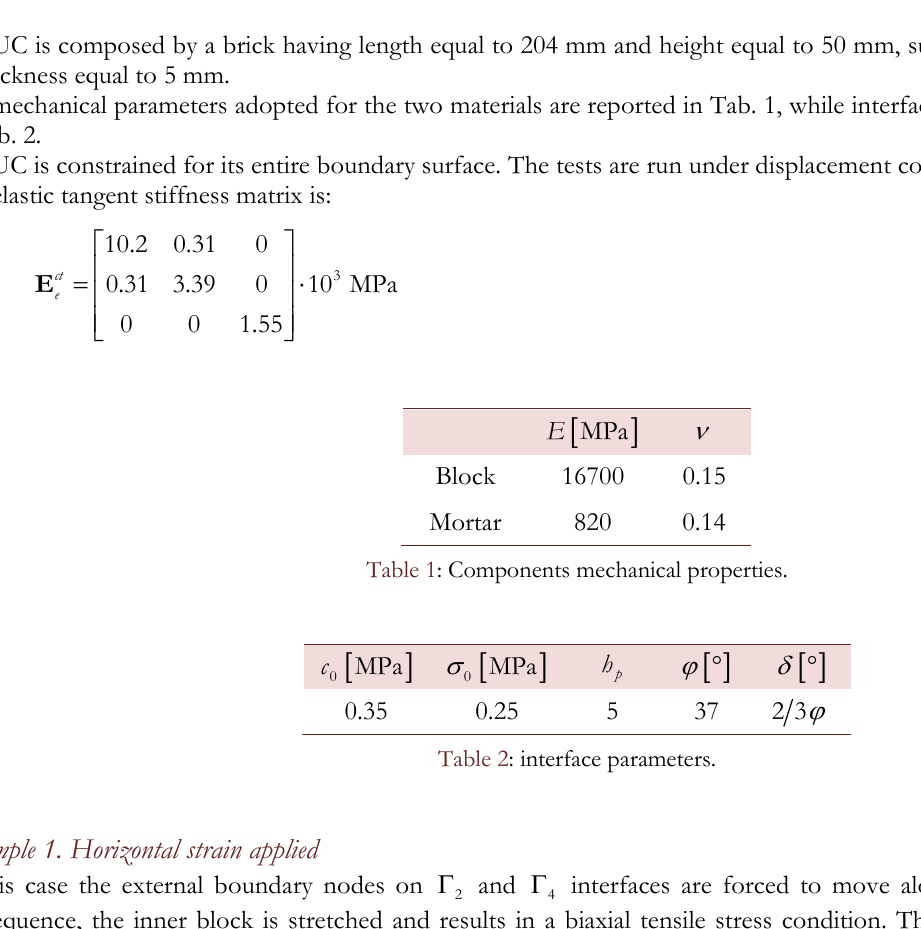
Figure 7: Boundary conditions imposed to the UC in the three examples analyzed.